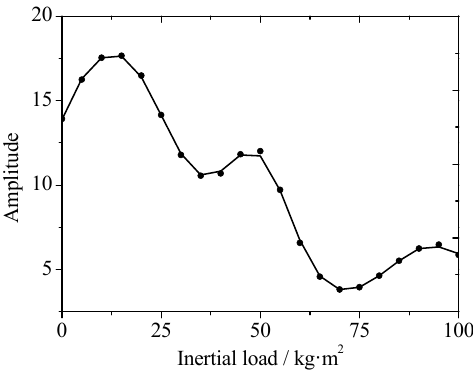
Energies 2018 , 11 , x FOR PEER REVIEW Figure 16. Radial vibration amplitude of planetary gear under different inertial loads.